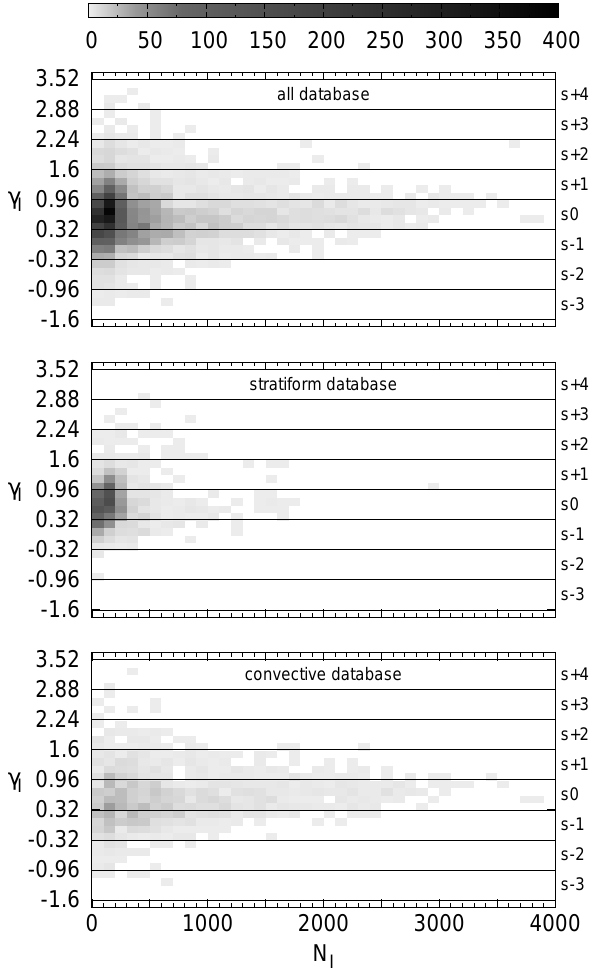
Fig.2. Theoccupancy O ( N I ,γ I ) fortheentire,stratiform,andconvectivedatasetsatDarwin. Horizontallines Fig. 2. The occupancy O(N I , γ I ) for the entire, stratiform, and denotetheskewnessclasses. convective datasets at Darwin. Horizontal lines denote the skewness